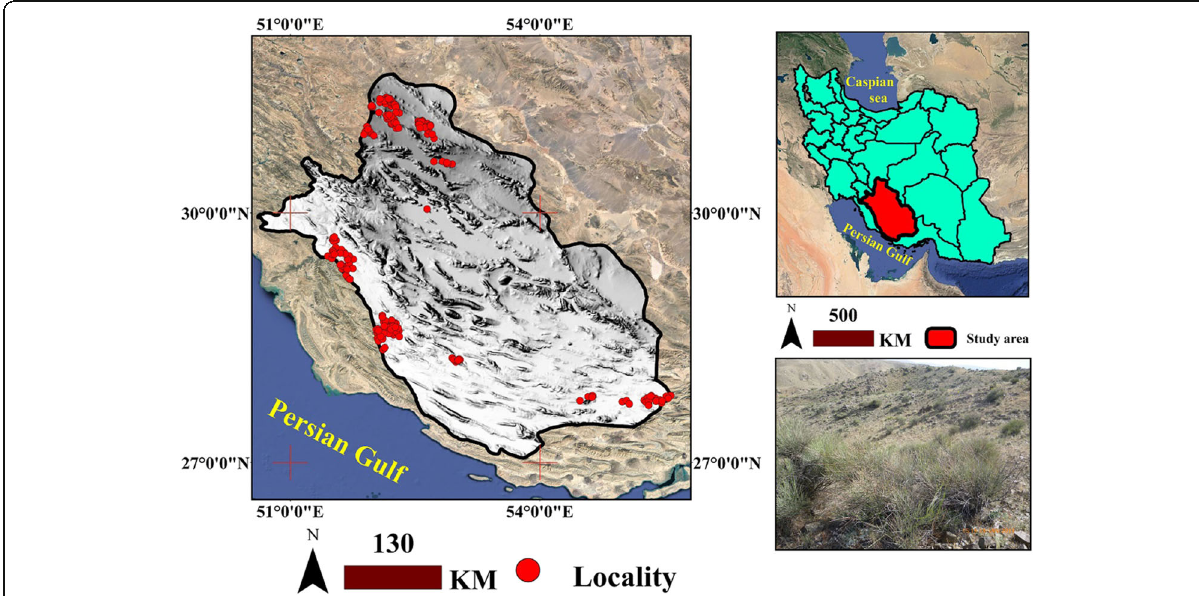
Fig. 1 Location of the study area and current habitats of Amygdalus scoparia (red points) in Fars Province, southern